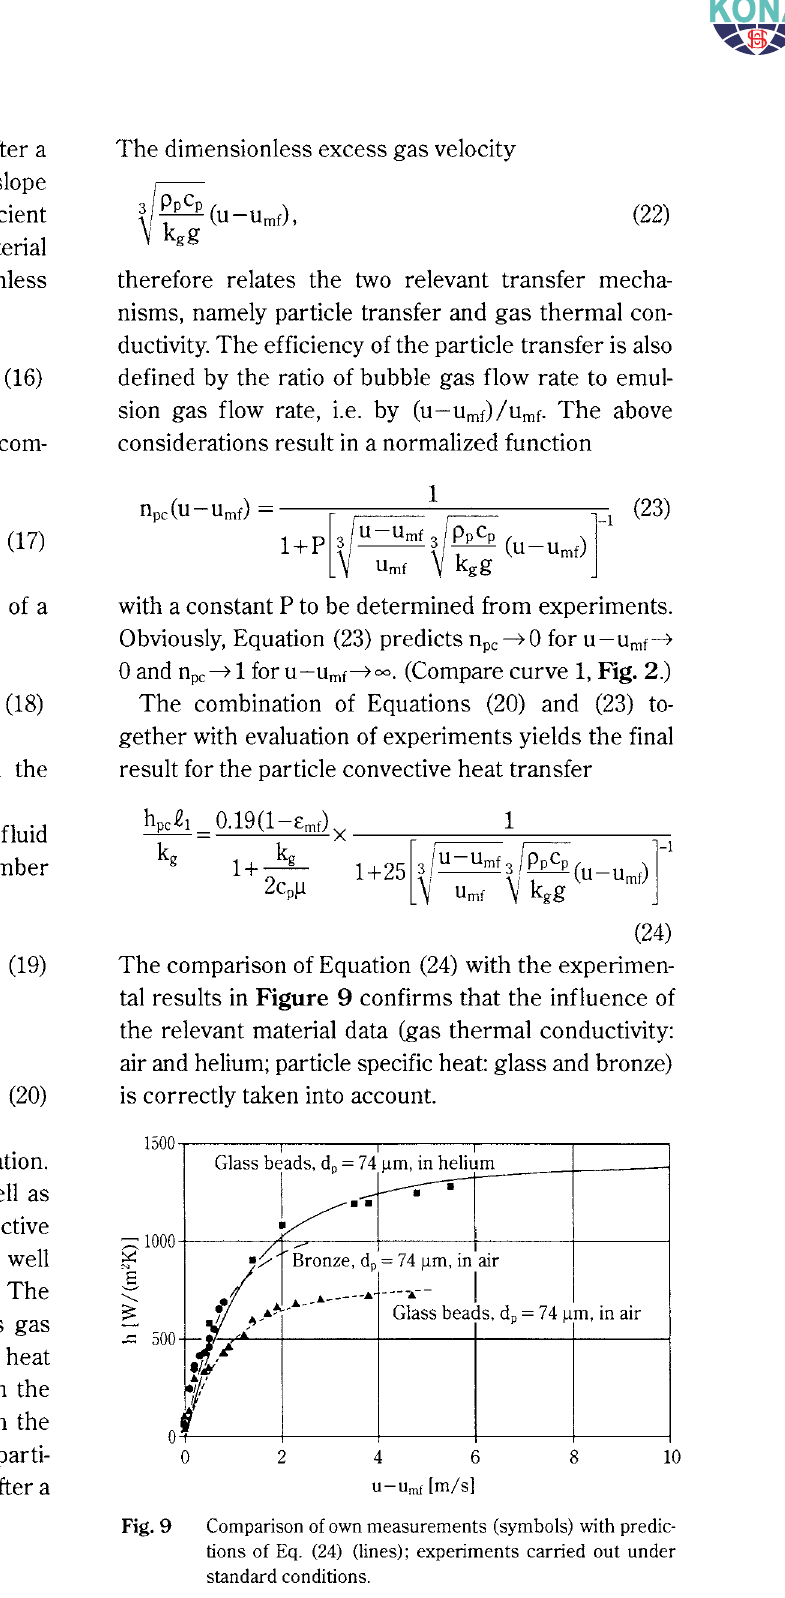
Comparison of own measurements (symbols) with predic tions of Eq. (24) (lines); experiments carried out under standard